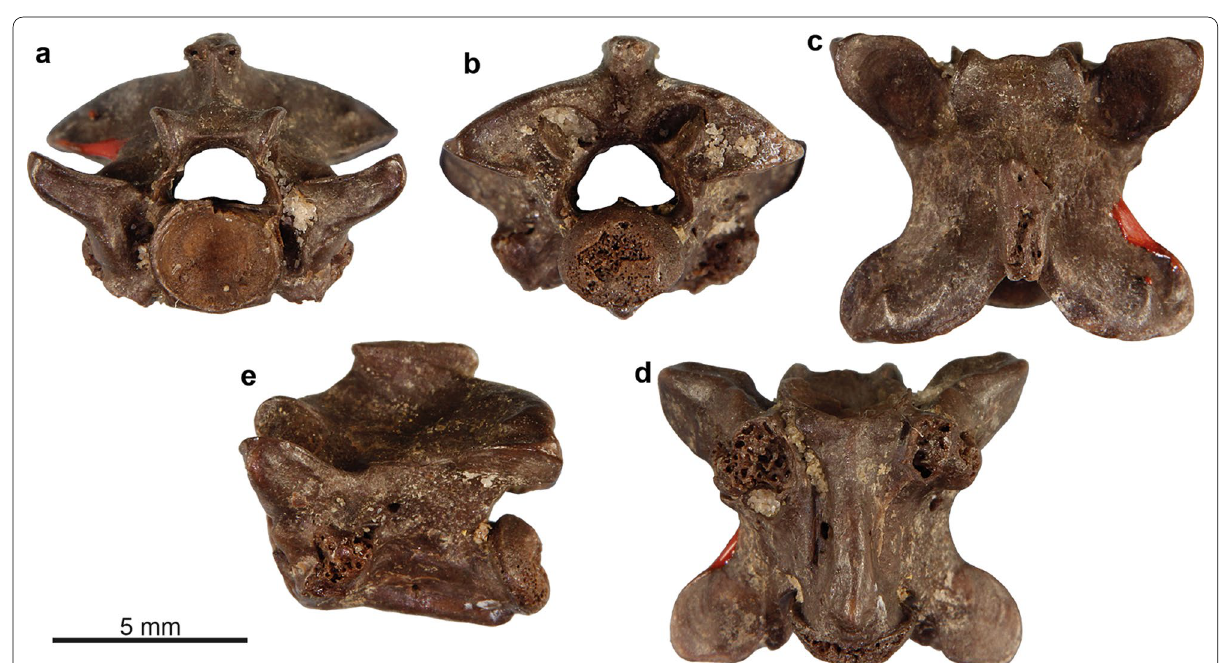
Fig. 37 Paleryx rhombifer from Hordle Cliff: posterior trunk vertebra (NHMUK PV OR 32838(1)) in anterior ( a ), posterior ( b ), dorsal ( c ), ventral ( d ), and left lateral ( e )